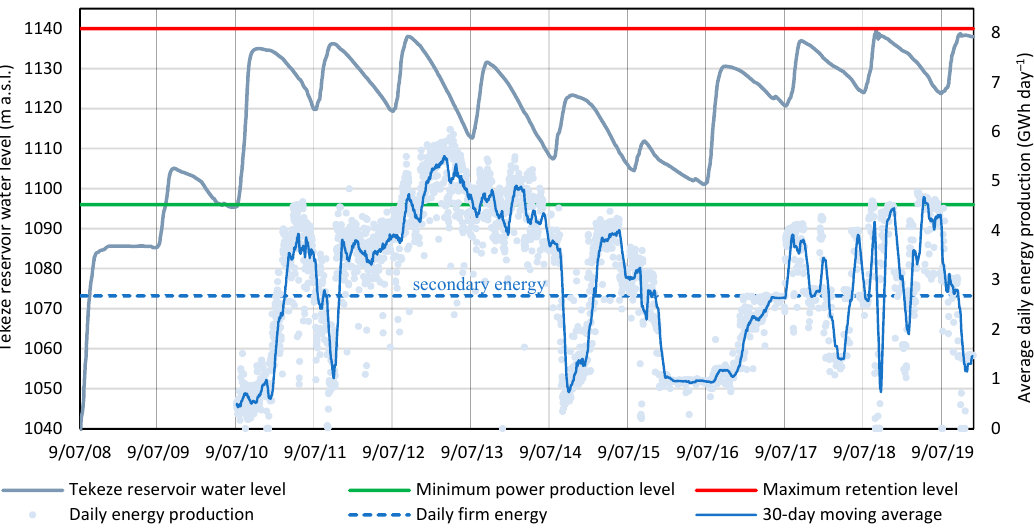
Figure 2. Evolution of the Tekeze Reservoir water levels from July 2008 and daily energy production from July 2010 to November 2019 (for this research, no energy production data are available before July 2010; Data source: [37,39]).